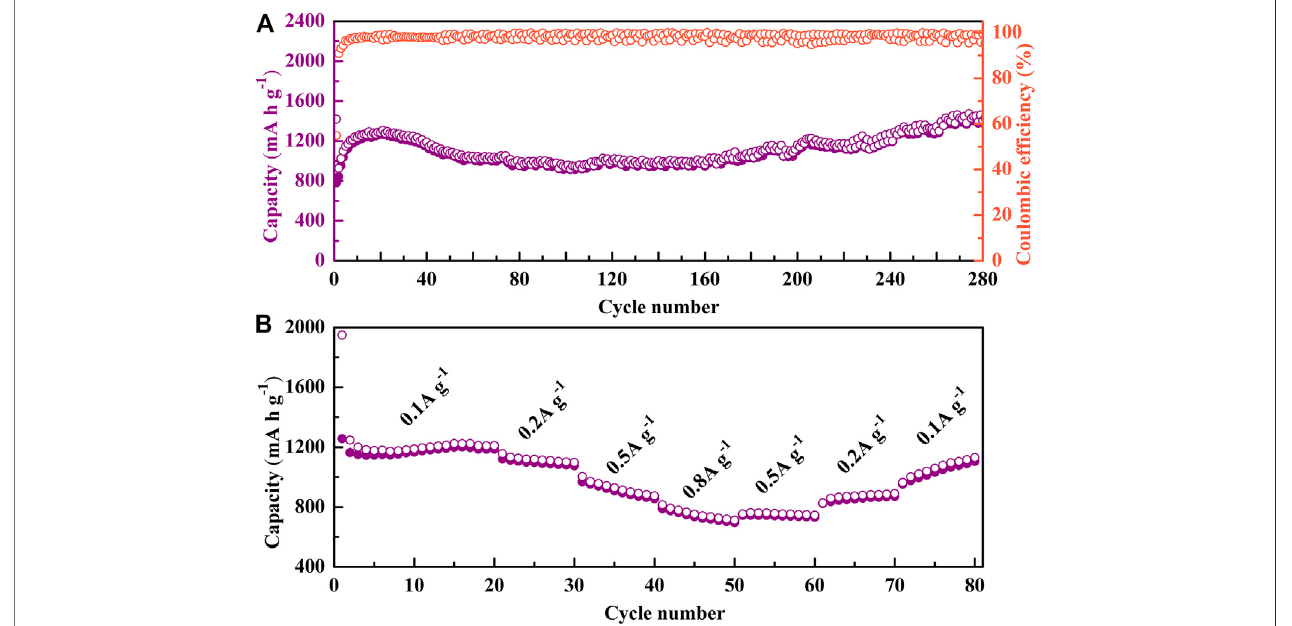
FIGURE 4 | (A) Cycle performance of NiS nanospheres. (B) Rate capabilities of NiS nanospheres.